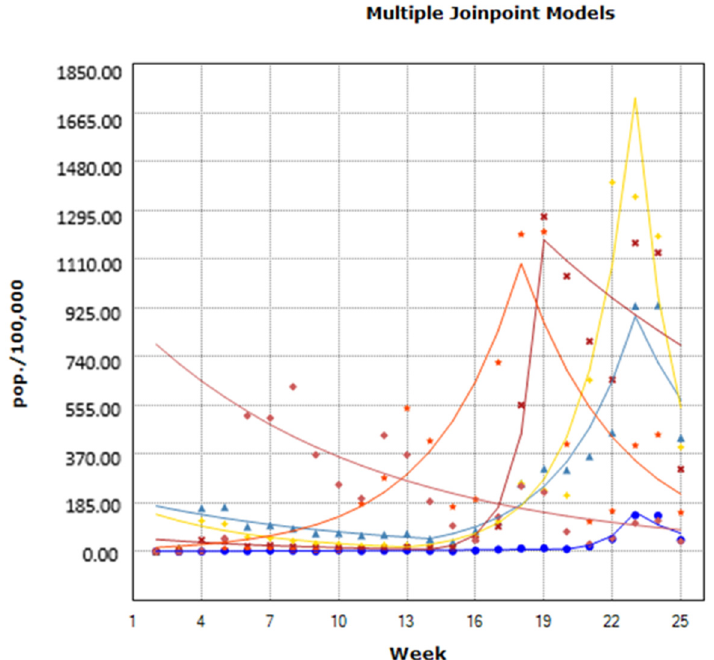
Figure 1. The weekly course of vaccinations per 100,000 population in Greece per age group (18–24 years: blue dots, 25–49 years: blue triangles, 50–59 years: yellow triangles, 60–69 years: red x, 70–79 years: orange asterisk, >80 years: red rhombus). The number on the y axis correspond to the number of vaccinations per 100,000 population. The X axis corresponds to weeks of vaccination.